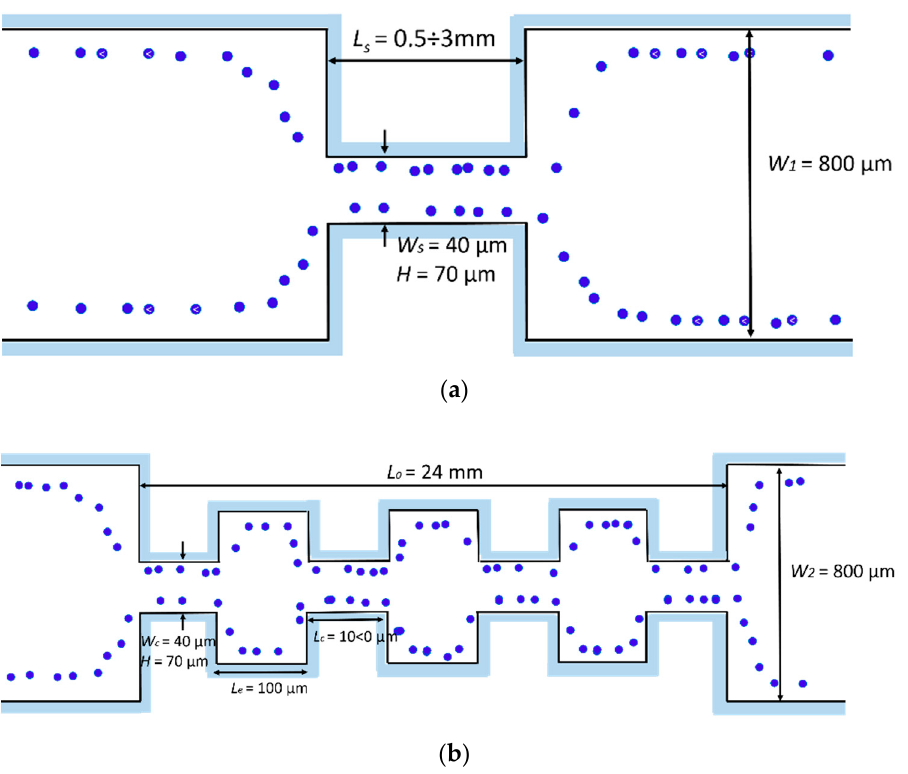
Figure 3. Design of the micro-channels used by Park et al. [81]. ( a ) Straight square channel. For the experiments, the micro-channel length was varied between 0.5 and 3 mm. ( b ) Multi orifice channel. All the structures are 70 μ m high ( H ). Adapted from [81].